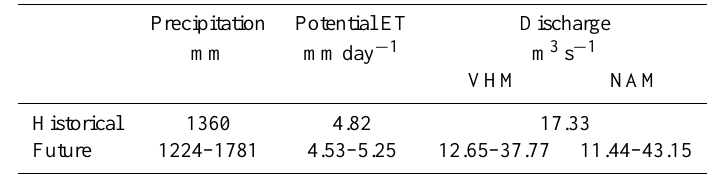
Table 3. Mean annual values of rainfall, ETo and flow of Nyando catchment for the baseline (1971–1990) and scenario (2046–2065) period.